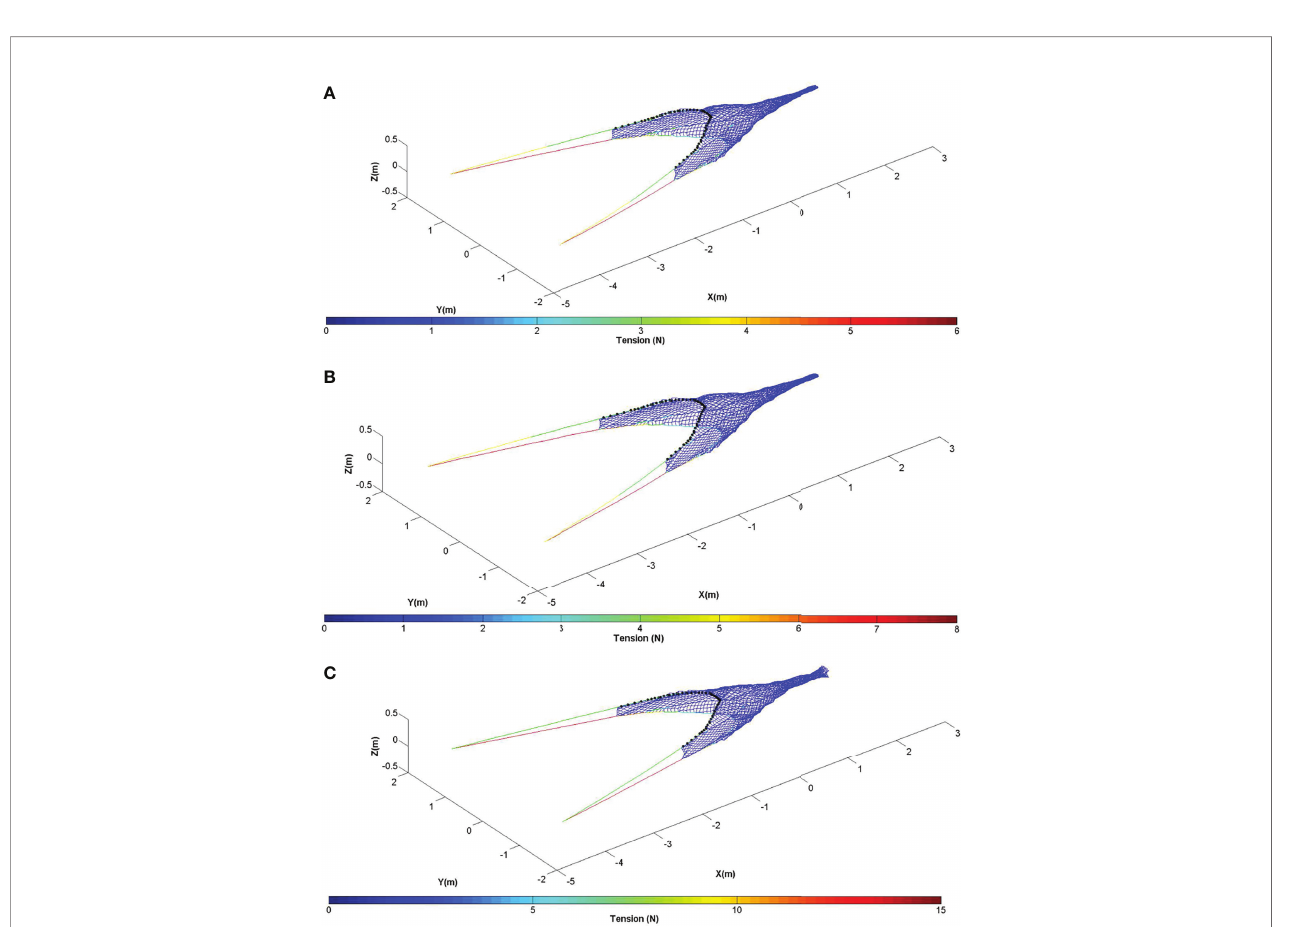
FIGURE 11 | Shape and tension distribution from numerical simulations of the model trawl at different speeds. (A) 3 kn (full-scale); (B) 3.5 kn (full-scale); (C) 4 kn (full-scale).